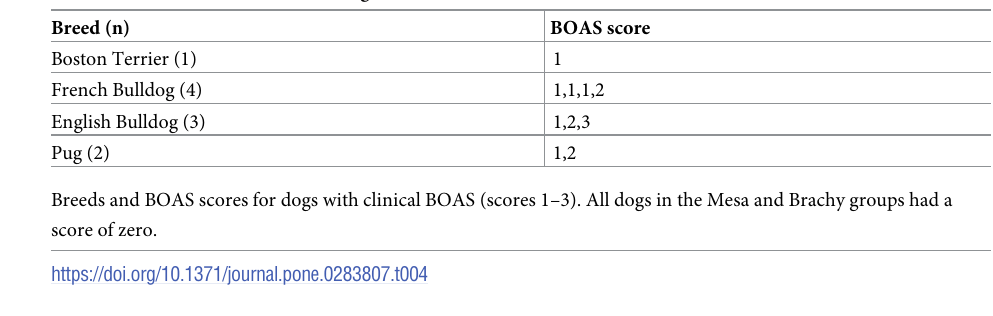
Table 4. Breed and BOAS score in dogs with clinical BOAS.